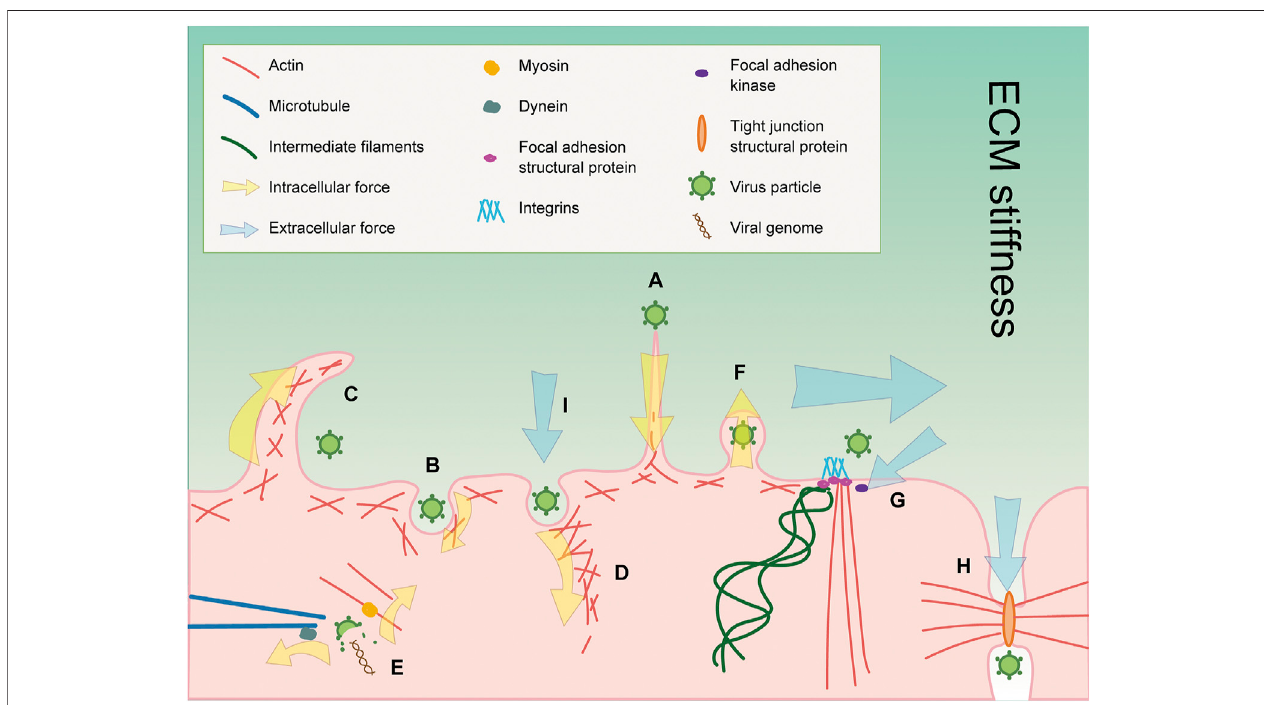
FIGURE 1 | Cytoskeleton and mechanosensors play crucial roles during viral infections. (A) Actin fi laments in host cells participate in virus sur fi ng before entering into the cells. (B) Actin fi laments provide forces for viral entry through clathrin-mediated endocytosis. (C) Macropinocytosis is employed by viruses for entry which is an actin-dependent process. (D) Actin monomers undergo rapid polymerization to generate forces for viral entry through caveolae-mediated endocytosis. (E) Microtubule and actin fi lament motor proteins dyneinand myosin may provide forces for virusuncoating, respectively. (F) Actin fi lamentsprovidebending force toexpelviruses to the extracellular environment. (G) Focal adhesion and FAK can sense extracellular mechanical signals such as shear force (horizonal arrow), tensile forces (slanting arrow), and ECM stiffness (gradient background color). Focal adhesion proteins can also affect viral infection in multiple ways. (H) Cell – cell junctions sense forces from intracellularandextracellularenvironments,andmaybeemployedbyvirusestofacilitatetheirinfection. (I) Caveolaesenseextracellularstress.Thenumber,morphology, and localization of caveolae are altered in response to stress and further affect viral